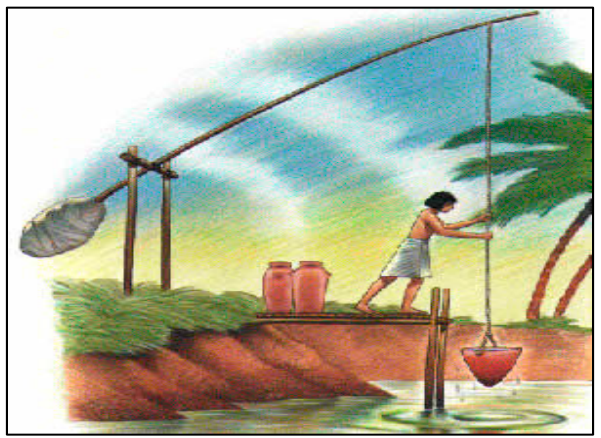
Figure 5. Egyptian Shaduf (adapted from [12]).